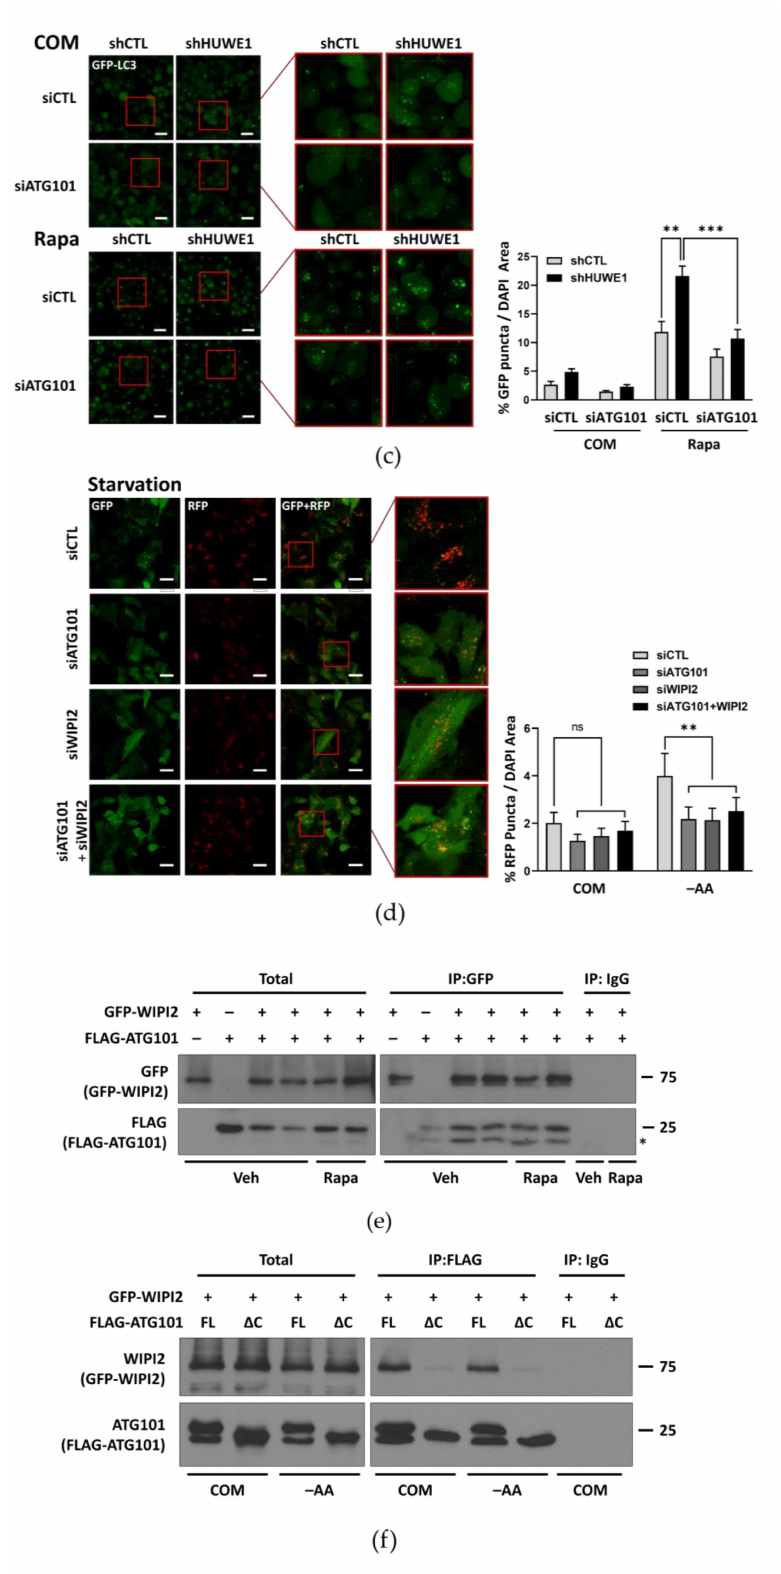
Figure 4. HUWE1 suppresses autophagy by regulating ATG101 and WIPI2 levels ( a ) HUWE1 KD enhanced GFP-LC3 puncta formation in MIA PaCa-2 cells. shCTL or shHUWE1 MIA PaCa-2 cells stably expressing GFP-LC3 were